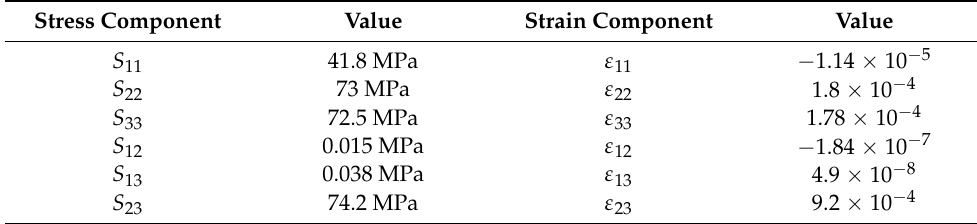
Table 4. The stress and strain components of the crankshaft (under the given load).